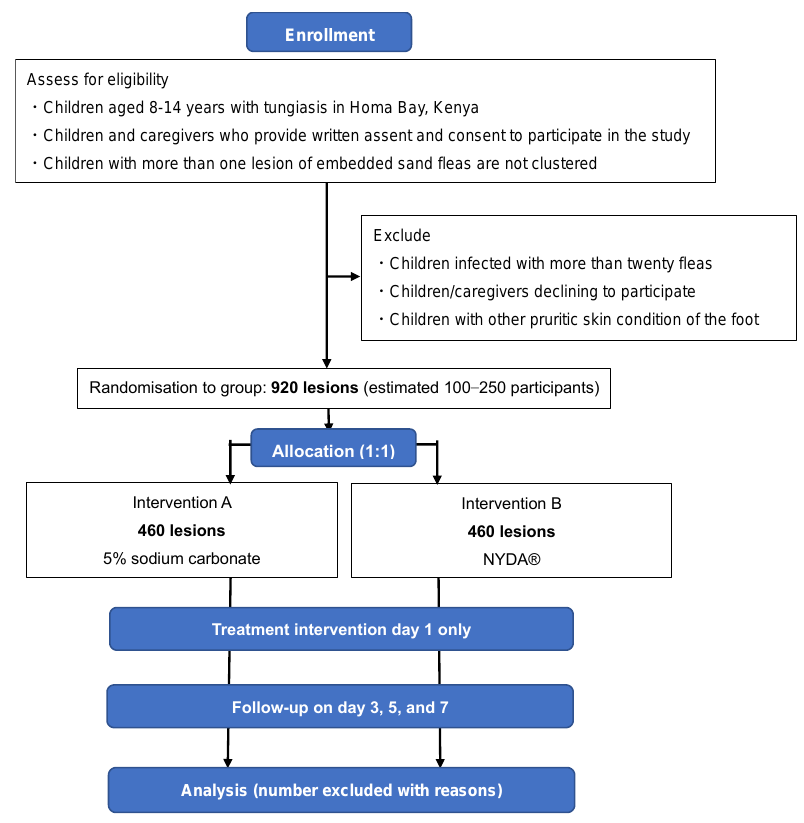
Figure 3. Flowchart of the study.